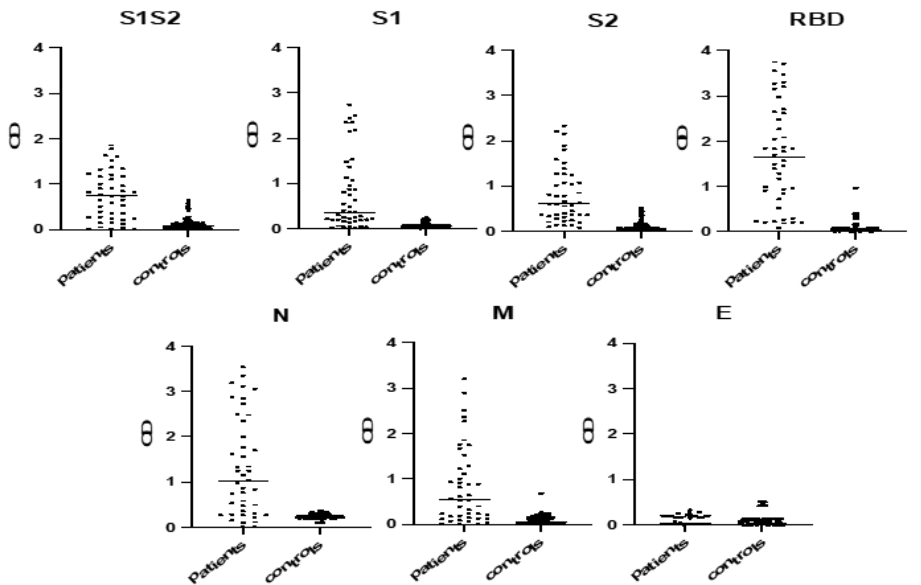
Figure 1. Immunoreactivity of different protein antigens in patients’ and controls’ sera. Sera (at a dilution 1:100) were tested against different capture antigens (RBD 2.5μg/mL, S1 1μg/mL, S1S2 dilution 1:100) were tested against different capture antigens (RBD 2.5 µ g/mL, S1 1 µ g/mL, S1S2 1μg/mL, S2 1μg/mL, M 2μg/mL, N 1.5μg/mL and E 5μg/mL). The cut-off value for each antigen was 1 µ g/mL, S2 1 µ g/mL, M 2 µ g/mL, N 1.5 µ g/mL and E 5 µ g/mL). The cut-off value for each antigen was determined using the mean optical density plus 2 SDs of normal controls. Black symbols represent the Optical Density (OD) value of each serum at 405